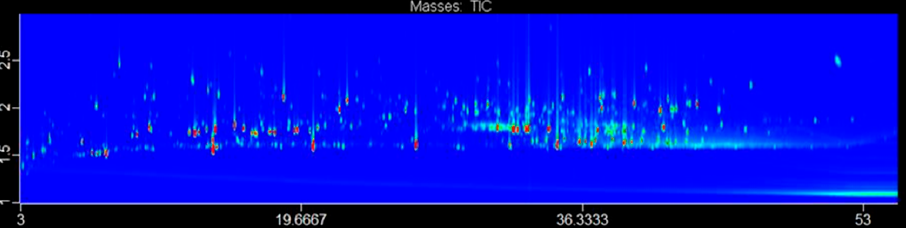
Figure A3. Example of a typical comprehensive GC × GC TOF MS contour plot of a test person, with x-axis denoting first dimension rt time in min (on non-polar column in Table A1), and y-axis denoting second dimension rt time is seconds (mid polar column in Table A1).